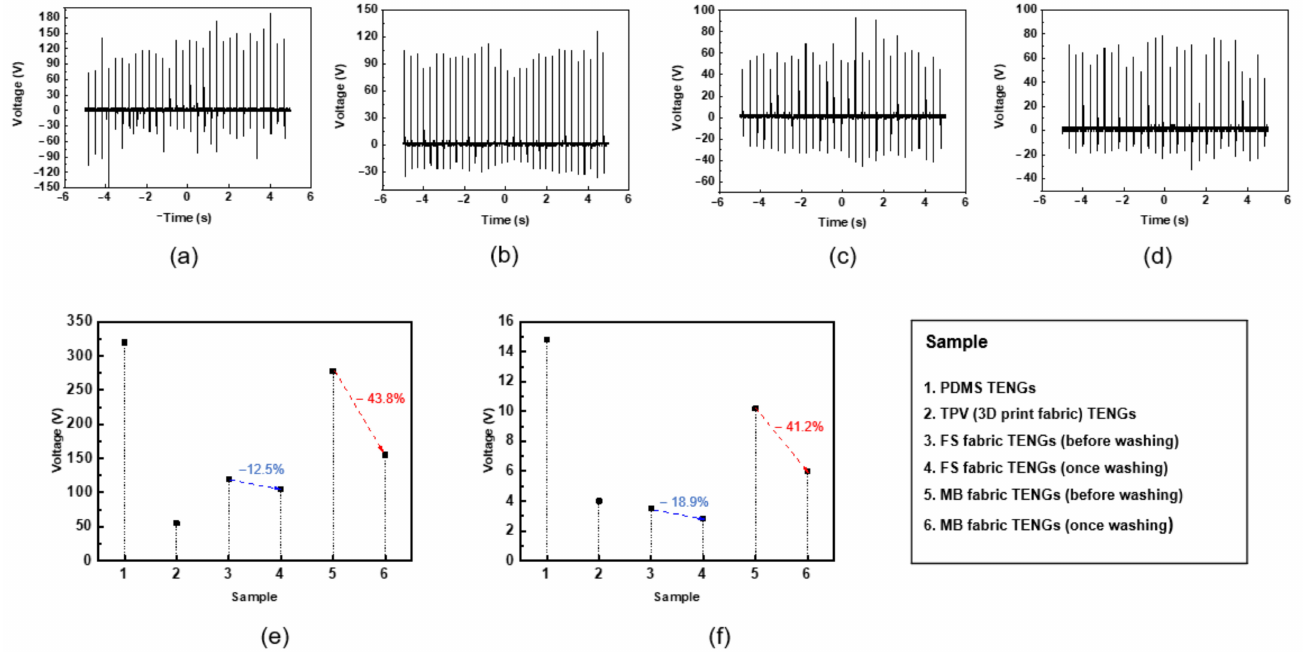
Figure 6. Output voltage of the FTENGs based on the MB fabric ( a ) before and ( b ) after washing and of the FTENGs based on the FS fabric ( c ) before and ( d ) after washing at high pressure (23 N). ( e ) Maximum peak-to-peak voltage of the FTENGs based on different fabric sheets at ( e ) high and ( f ) low pressure (2.2